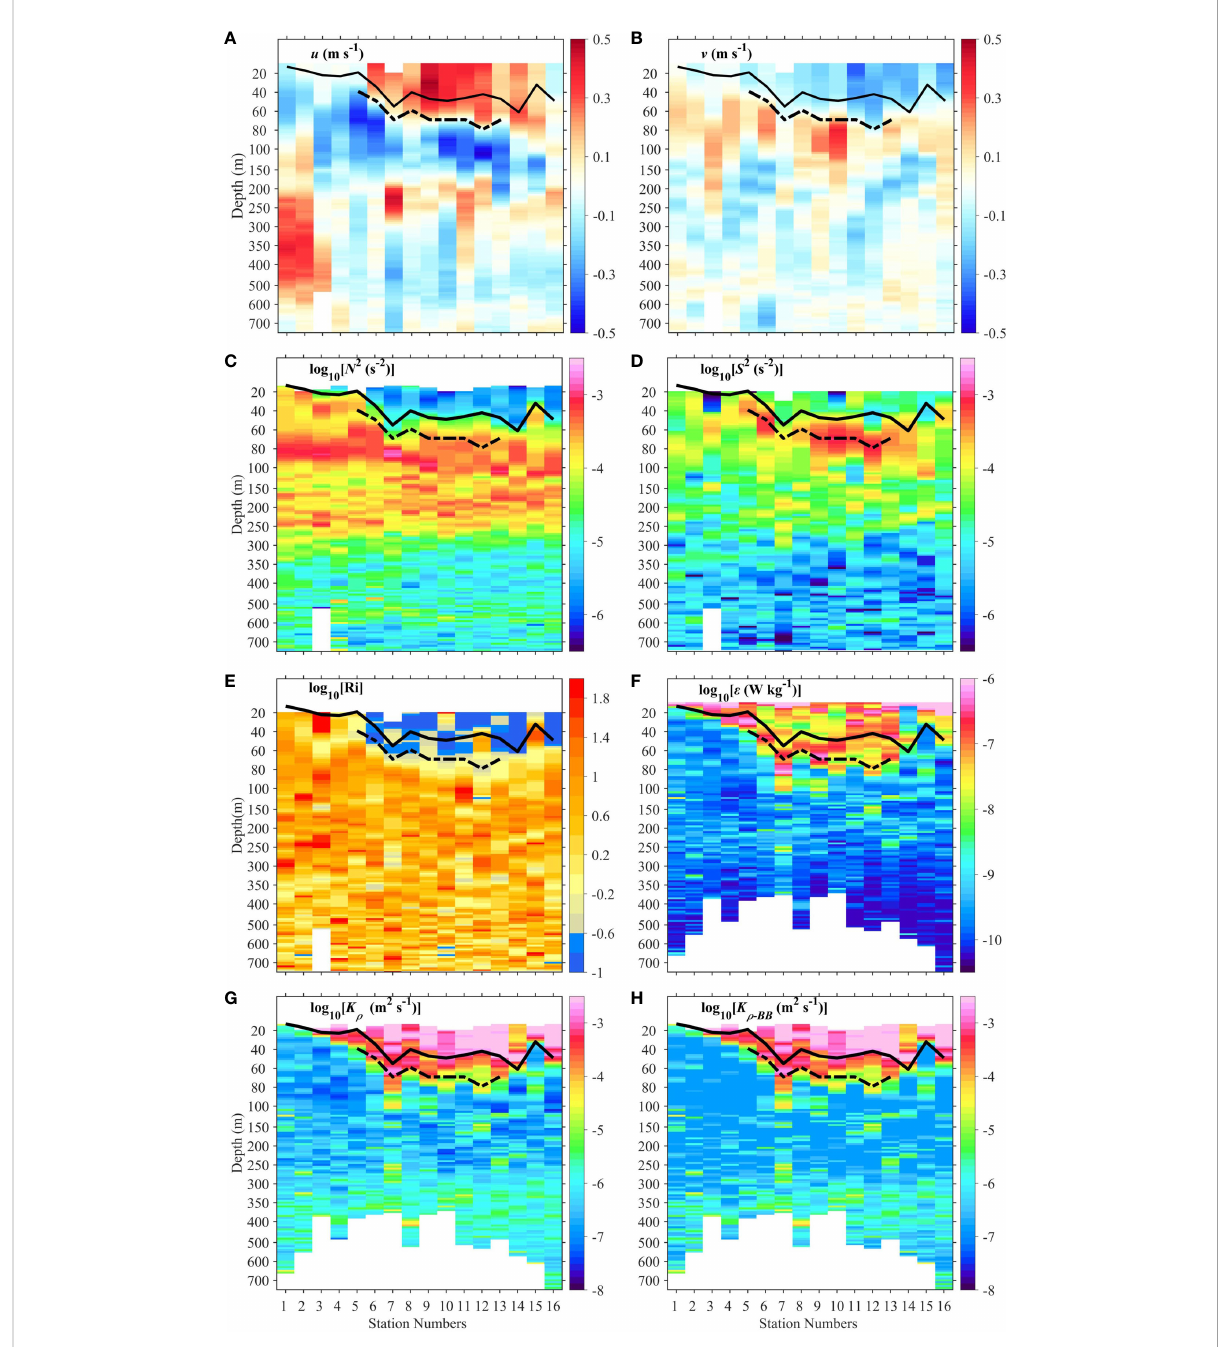
FIGURE 4 Depth-station variations of observed (A) zonal velocities ( u ), (B) meridional velocities ( v ), (C) squared buoyancy frequency ( N 2 ), (D) shear variance ( S 2 ), (E) Richardson number (Ri), (F) TKE dissipation rate ( e ), and (G) diapycnal diffusivity calculated from Osborn relationship ( K r ) and (H) from Bouffard and Boegman (2013; K r -BB ). The thick solid and dash-dotted lines indicate the bases of the mixed layer and the deep cycle turbulence layer, respectively. Note that the y -axis is not